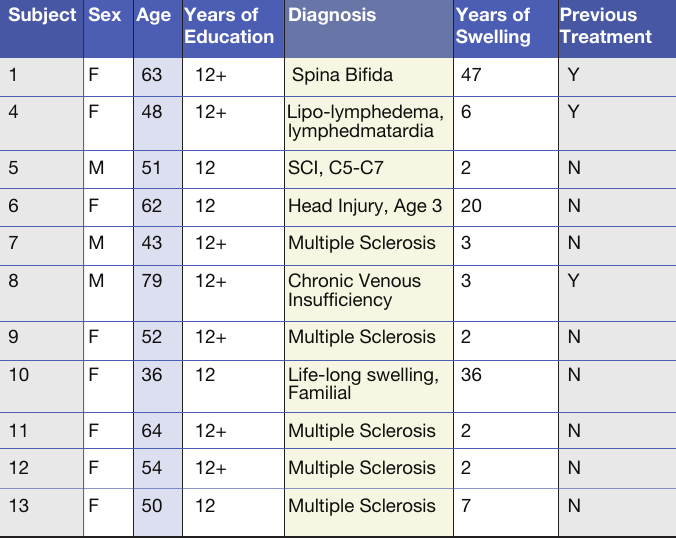
Table 1. Participants’ demographic characteristics (N = 11)